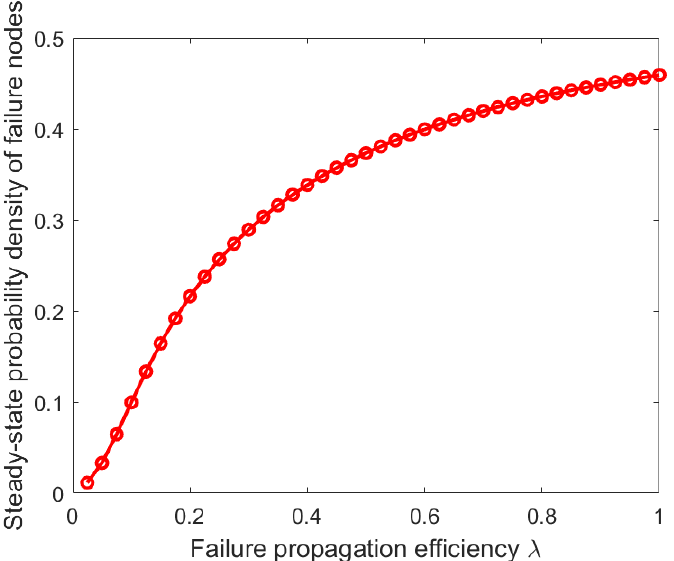
Figure 11. Propagation process of failure in 118-node power grid based on the SIS model. The synergistic propagation of failures in the overall cyber-physical power system is shown in Figure 12 by the change in infected density (Count%) with time (T). Failures spread rapidly and reached a maximum at t ≈ 50, then eventually converged to a more stable state. The sum of failure nodes and normal operating nodes is the total number of nodes, 2N, in the two-layer system.